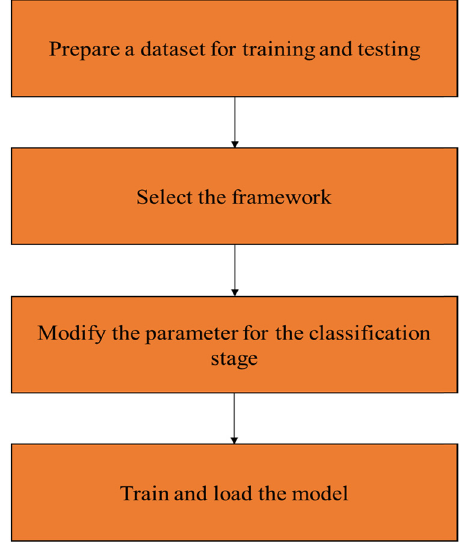
Figure 1: Basic steps for network parameter modi fi